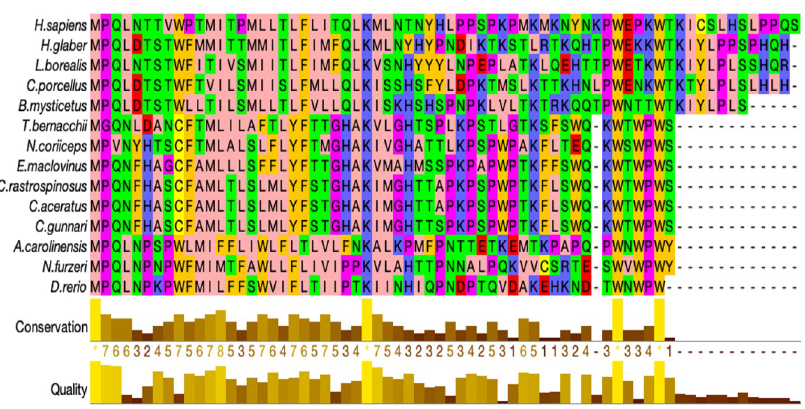
Fig 3. Multiple sequence alignment of ATP8 protein sequences. The ATP8 protein sequences were aligned using Clustal omega and edited using zappo colour scheme in JalView. Notothenioidei are grouped together in blue; all species are displayed to the colour corresponding to their phylogenetic closeness. (Colours according to physio- chemical properties of amino acids; Aliphatic/hydrophobic-A, I, L, M, V- light pink; Aromatic-F, W, Y- mustard; Conformationally special- Glycine, P- magenta; C-yellow; Hydrophilic- N, Q, S, Q, T- light green; Negatively charged/ D,E-Red; Positively charged/R,H,K-Blue) in jalview. The bar-graphs below represent a quantitative measure of conservation at each position. The figure was created using